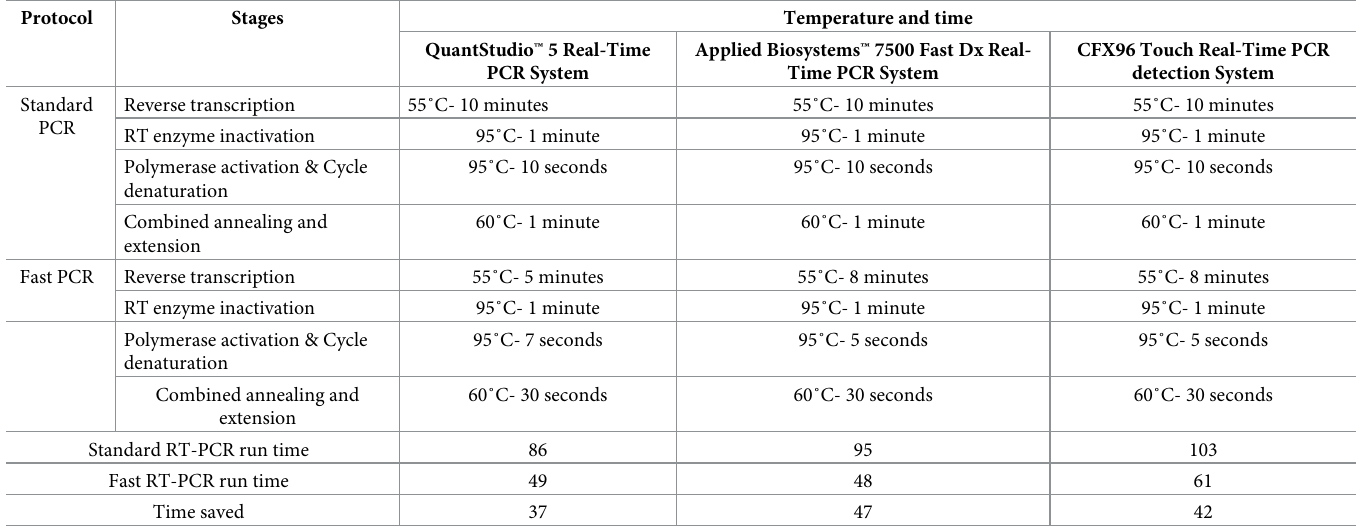
Table 1. Comparison of run time and time saved between standard PCR and optimized Fast RT-PCR